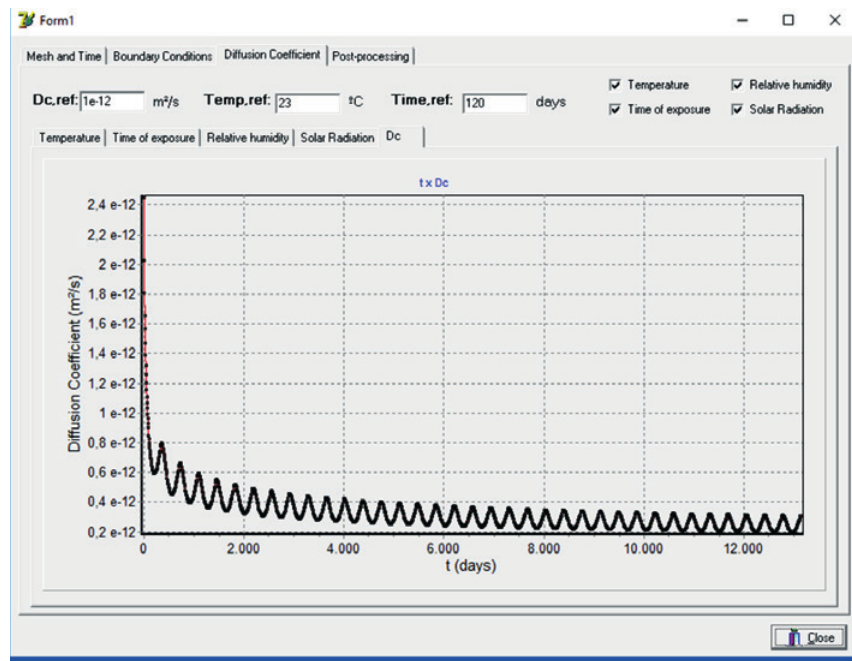
Figura 2 Interface do software